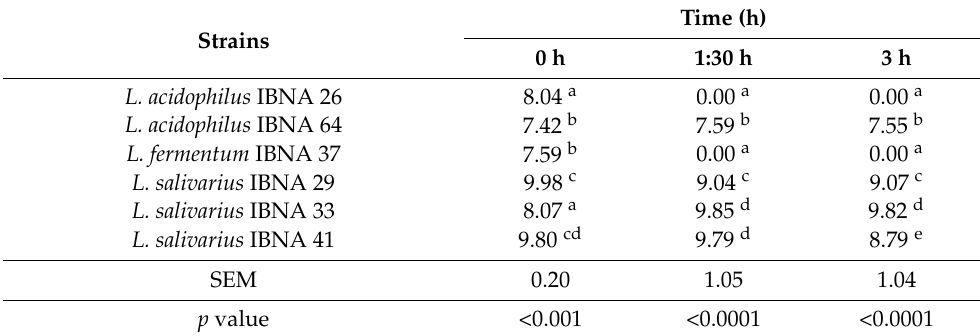
Table 4. Viability of Lactobacillus isolates during 3 h of incubation in 0.3% bile salt.